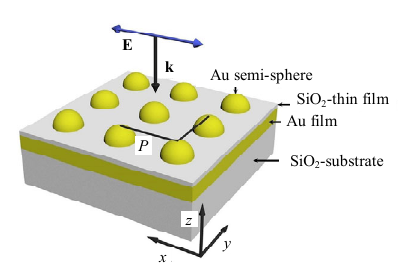
Fig. 6 3D geometric structure of the 2D grating composite structure. From top to bottom, the components consist of the 2D gold semi-sphere particles array, silicon dioxide thin film, gold film, and silicon dioxide substrate (the black arrow indicates the direction of propagation of the incident light, the blue arrow indicates the polarization direction, and the black line shows the period).